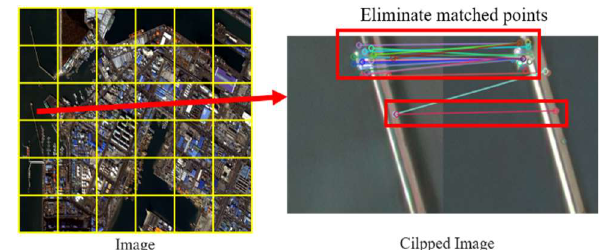
Figure 4. Eliminate matched feature points on clipped bucket